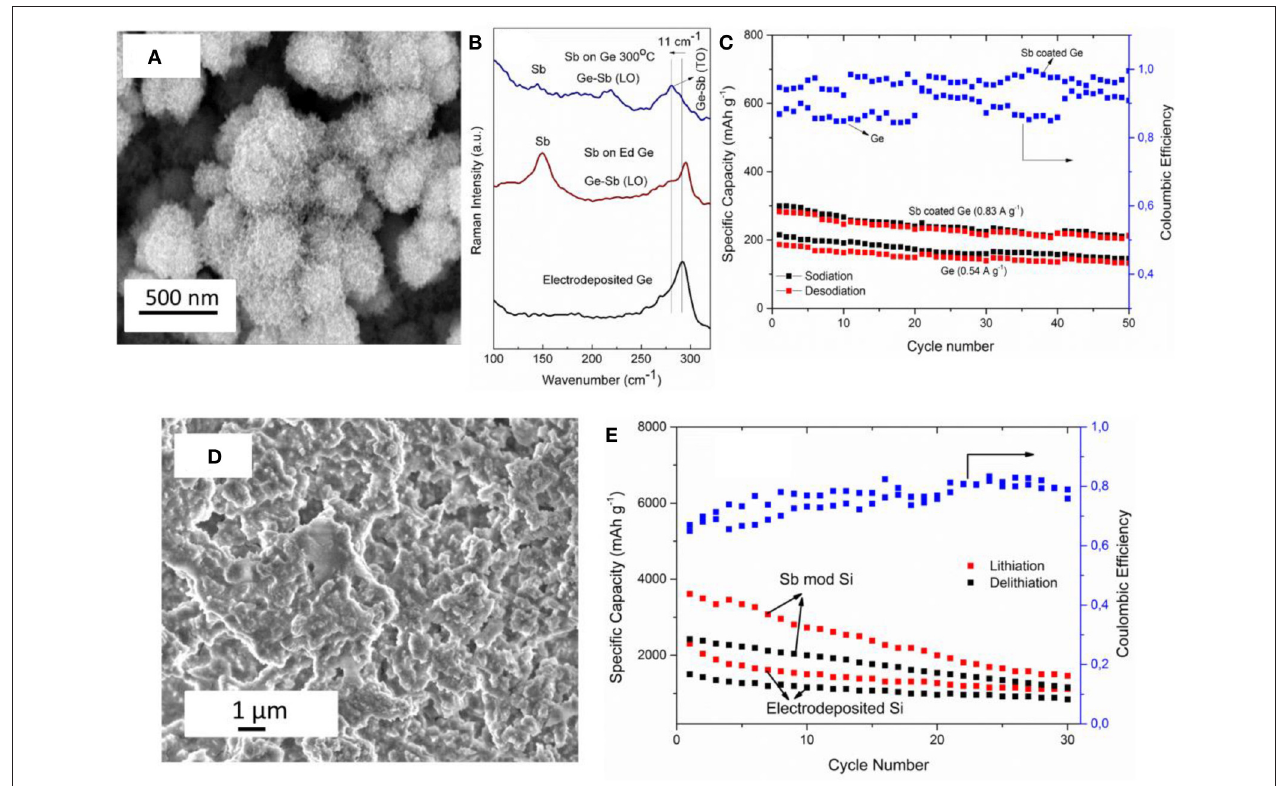
FIGURE 5 | (A) Microstructure of Sb modified Ge nanoparticles (B) Raman spectra of electrodeposited Ge (black line), electroless deposited Sb on Ge (red line) and after annealing to 300 ◦ C (blue line) (C) SEM of electroless deposition Sb on silicon (D) Charge-Discharge cycles of electrodeposited Ge and Sb modified Ge for Na-ion batteries in 1M NaFSA-[Py 1,4 ]FSA (E) Charge-Discharge cycles of electrodeposited Si and Sb modified Si for Li-ion batteries in 1M LiTFSA-[Py 1,4 ]TFSA. Reproduced from Lahiri et al. (2016) and Lahiri et al. (2017) with permission from The Royal Society of Chemistry and American Chemical Society. Copyright 2017 American Chemical